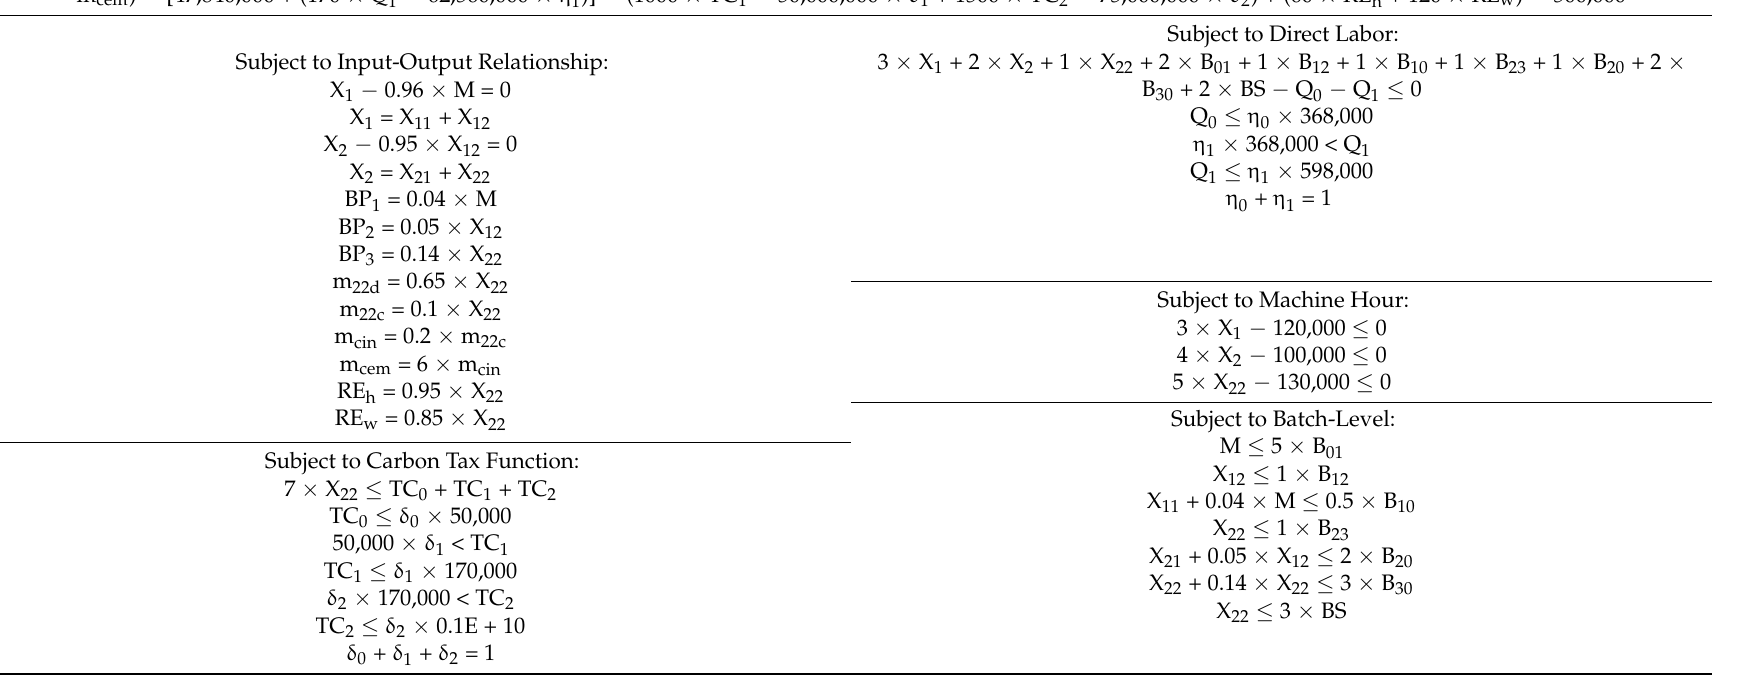
Table 3. Green production planning model for the example